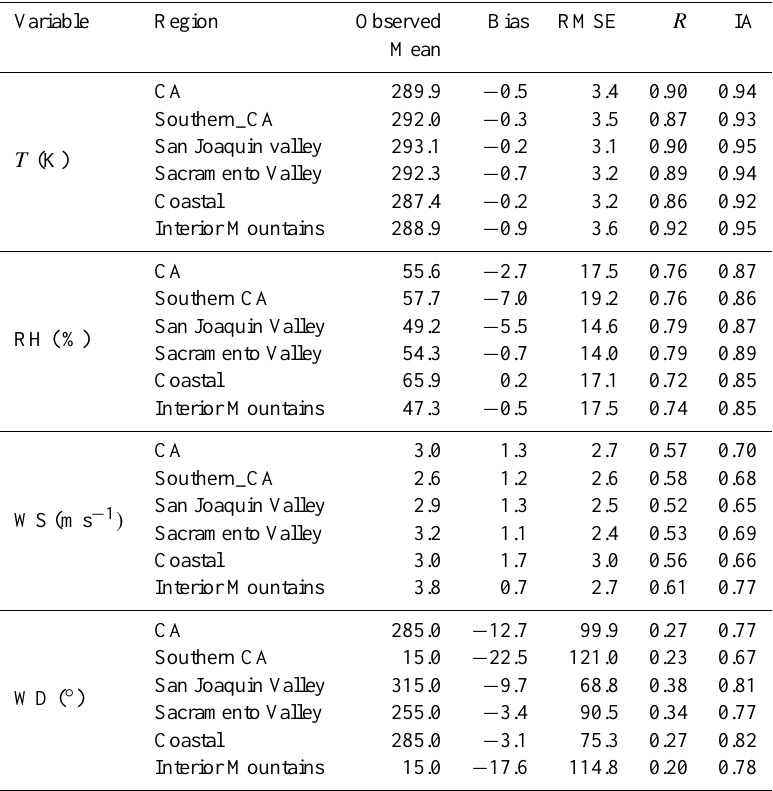
Table 4. Performance of simulated temperature (T), relative humidity (RH), wind speed (WS), and wind direction (WD) in terms of bias, root-mean-square error (RMSE), correlation coefficient ( R ), and index of agreement (IA) for the surface stations depicted in Fig. 1c. Statistics given for all of California (CA) and by region (Fig.